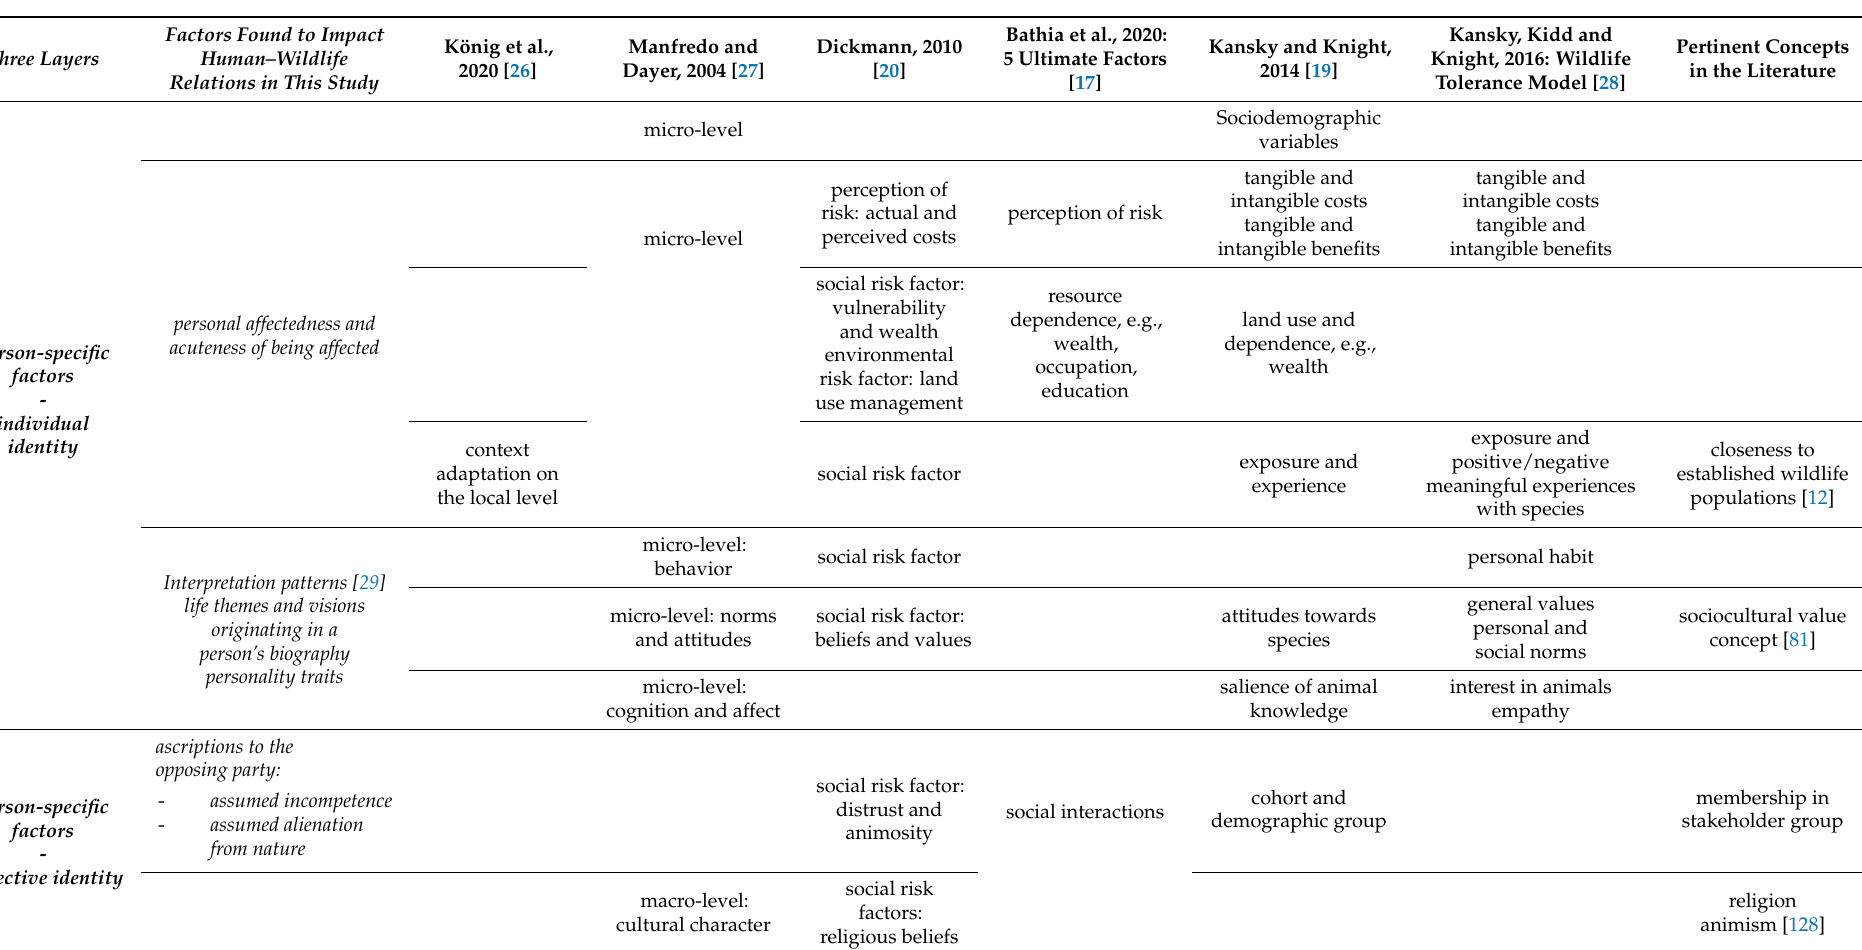
Table A1. Corresponding levels and concepts found to impact human–wildlife relations in extant models and within the three-layer framework of this